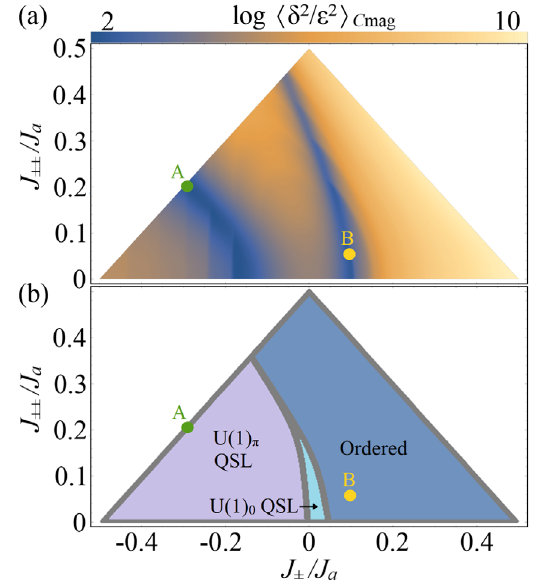
) for the C mag FIG. 5. The regions of the XYZ phase diagram for which it is , as mag possible to obtain simultaneous reasonable NLC descriptions of χ , J ¼ − 1 4 ð J b þ J c Þ , a (cid:3) and C are indicated in green and yellow for ð J ˜ mag to the different permutations of ð J thresholds for reasonable χ and C descriptions for the permutation in which ð J ˜